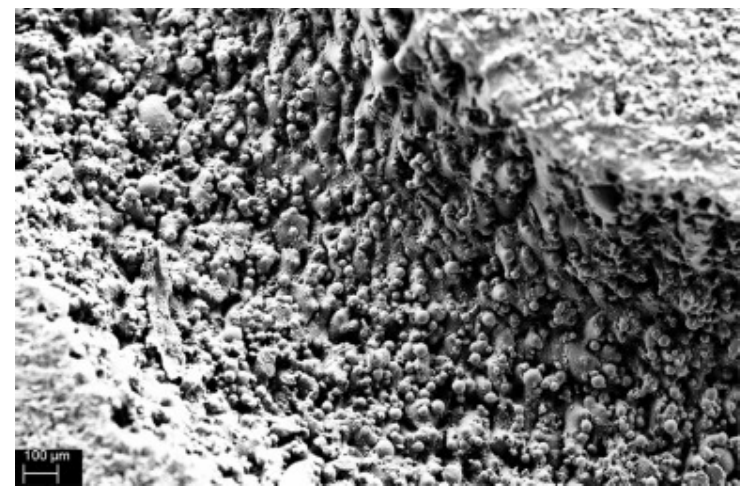
Figure 20. Microscope view of the internal structure of the AM oscillating HP [44,45]. Tabulated below (Table 1) is a comparison between the most important recent devel- opments of using AM technology in constructing wicks, HPs or LHPs.